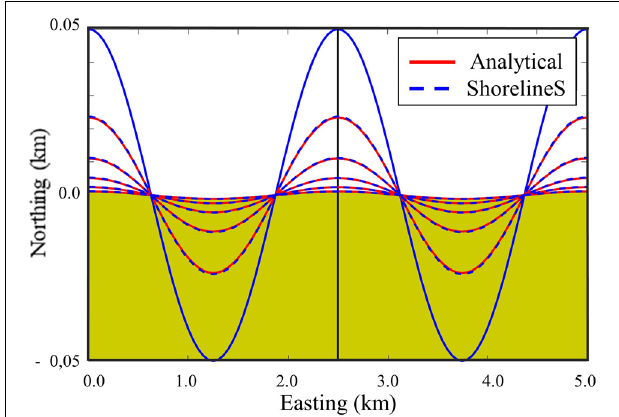
FIGURE 4 | The diffusion test result using the adaptive time step; results shown every 6 years.